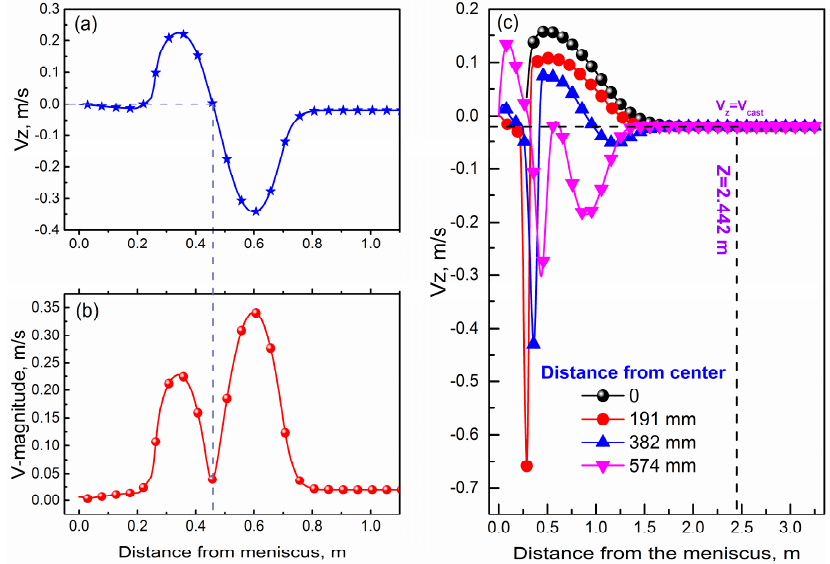
Figure 5. ( a ) z -component of velocity and ( b ) velocity magnitude variation of the line with 10 mm from the narrow face at the central symmetry plane. ( c ) z -component of the velocity variation of different lines at the central symmetry plane of the strand narrow face.